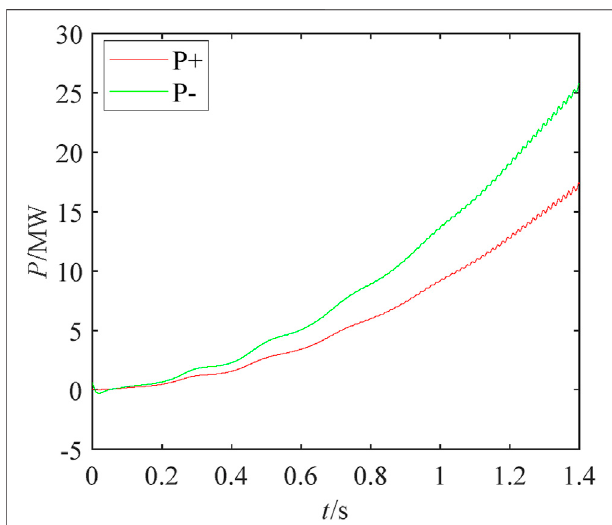
FIGURE 8 | Instantaneous power of abnormal grounding at different positions of